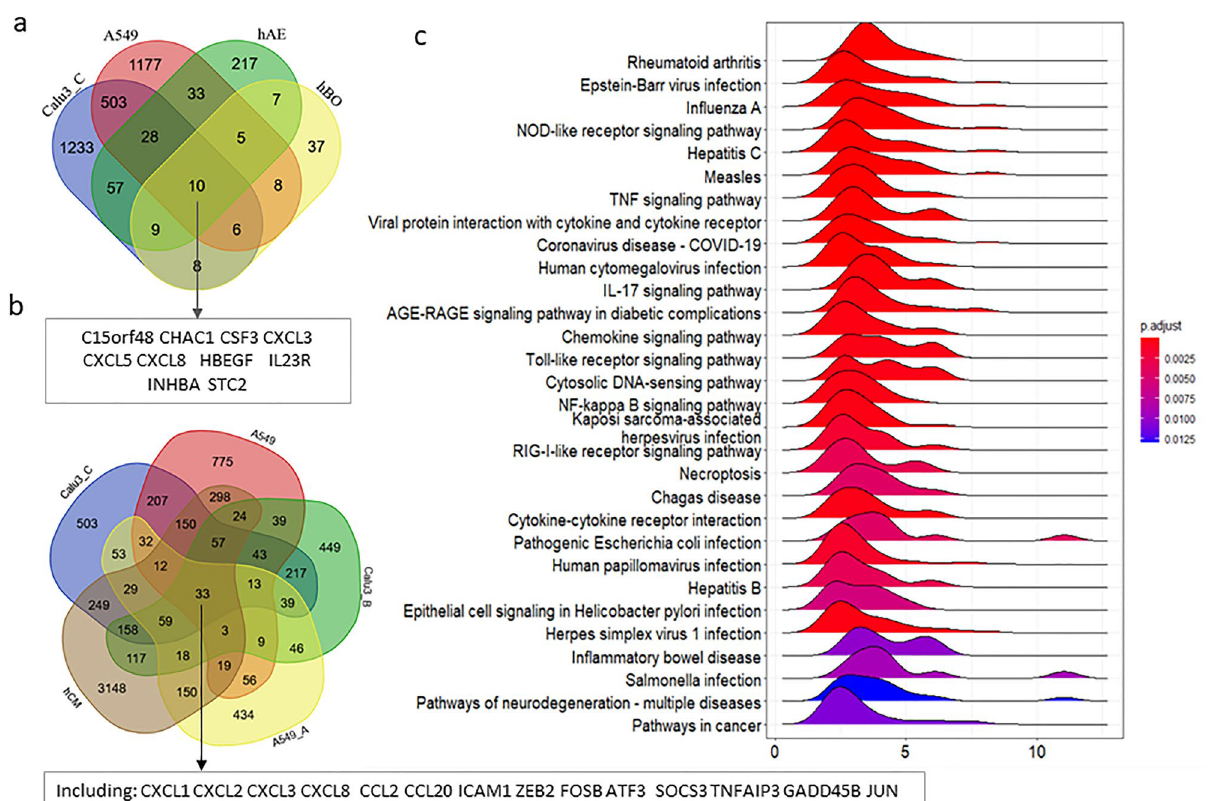
Figure 5. hACE2 expression and SARS-CoV-2 infection. ( a ) A Venn Diagram showing the 10 common DEGs in the 4 samples with low level of infection, including A549, hAE, hBO, and Calu3_C cells. ( b ) A Venn Diagram showing the partial list of common DEGs in the 2 samples with low level of infection (A549 and Calu3_C cells) and 3 samples with high level of infection (A549-hACE2, hCM, and Calu3_B cells). ( c ) Top 30 KEGG pathways enriched with DEGs of SARS-CoV-2 infection in Calu3_C cells. A549_A represents A549 with hACE2 overexpression. Calu3_B and Calu3_C represent data by Wyler E. (bioRxiv) and Blanco-Melo D. (Cell),